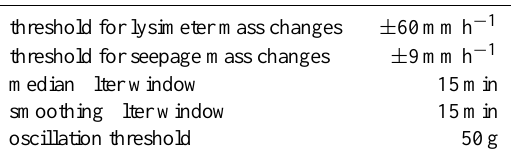
Table 1. Parameters for the different filters in the basic process- ing approach that were used as standard. If no other information is given, the calculations refer to these